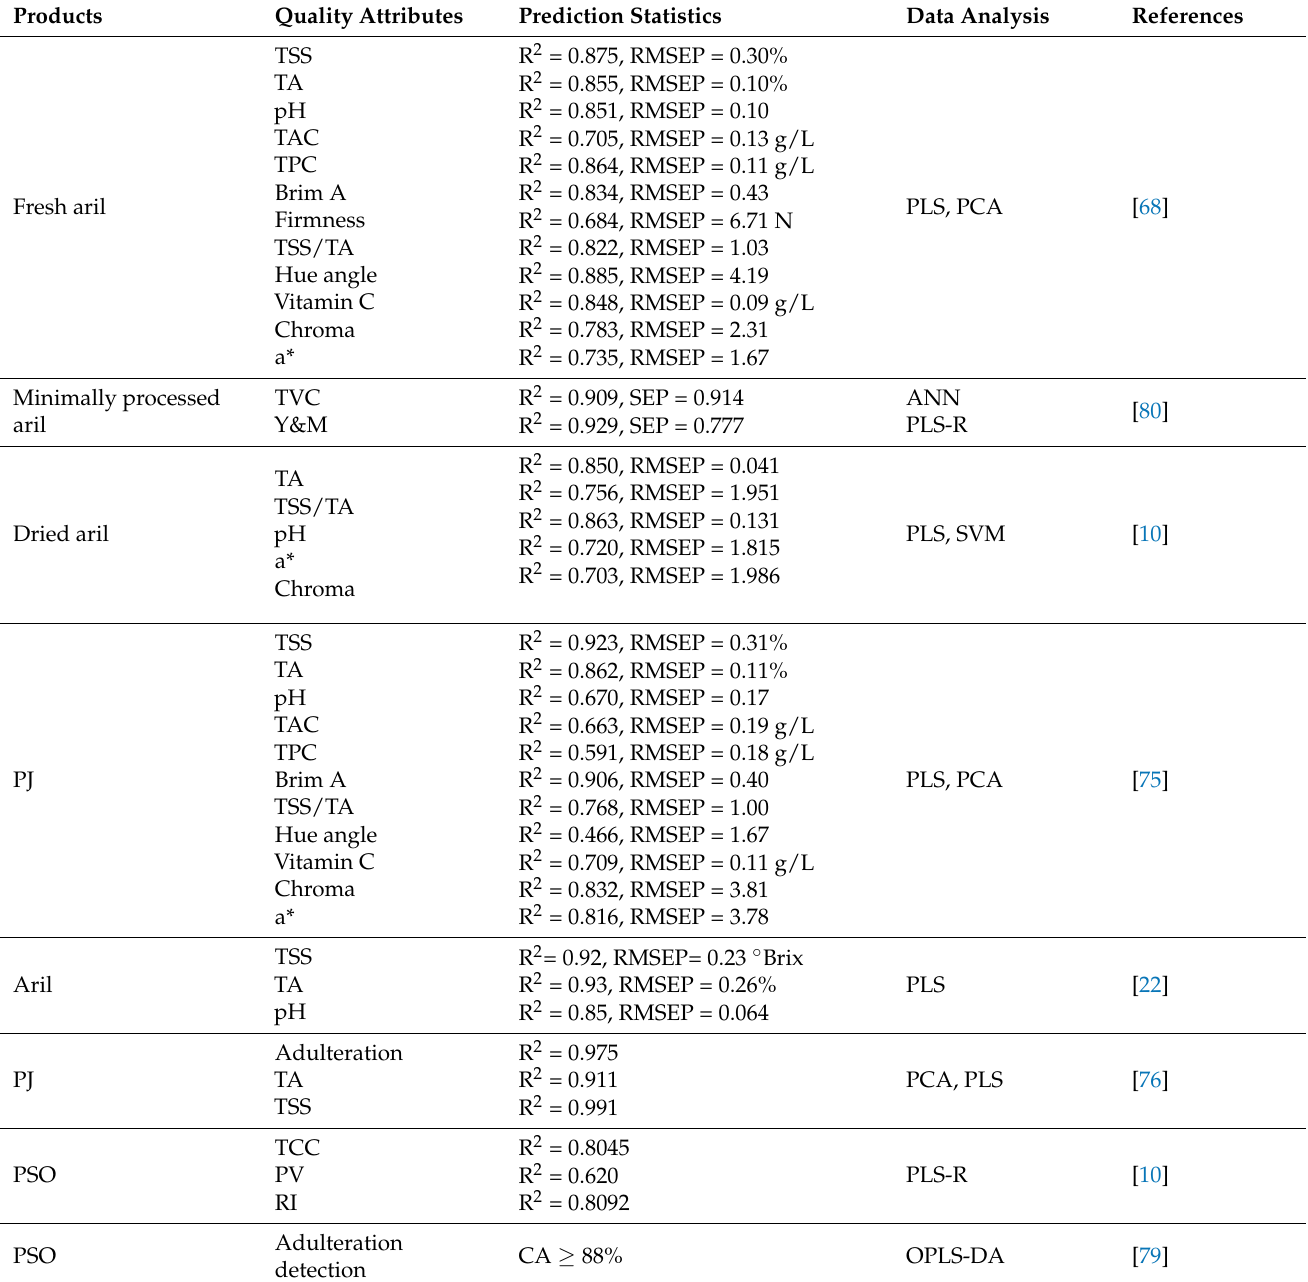
Table 3. Summary of application of Vis/NIR spectroscopy for processed pomegranate product quality